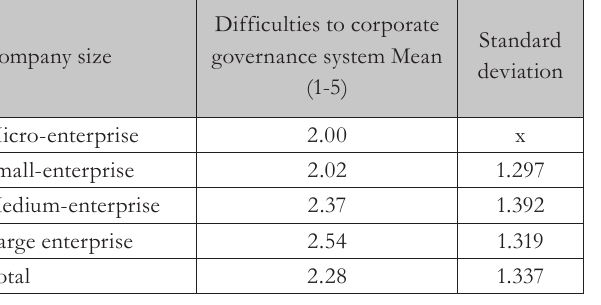
Tab. 2 – The level of difficulties to corporate governance system Source: own